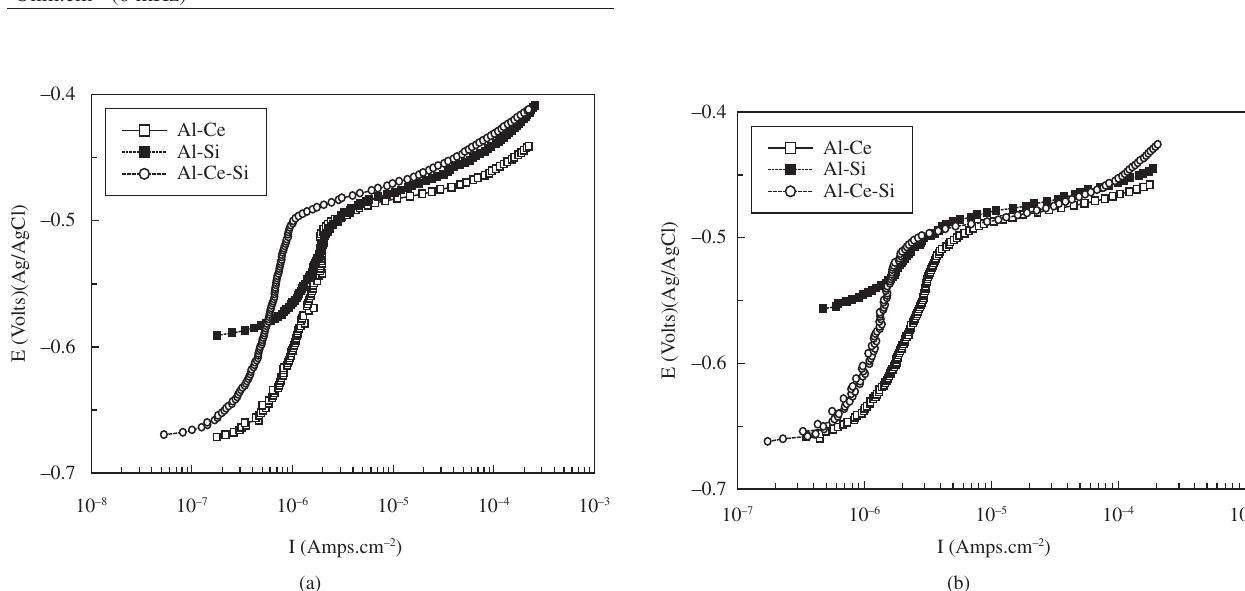
Figure 7. Anodic polarization curves in 0.1 M NaCl solution for AA 2024-T3 with different treatments. Curves obtained after the impedance experiments presented in Figure 6; a) non-sonicated; and b) sonicated